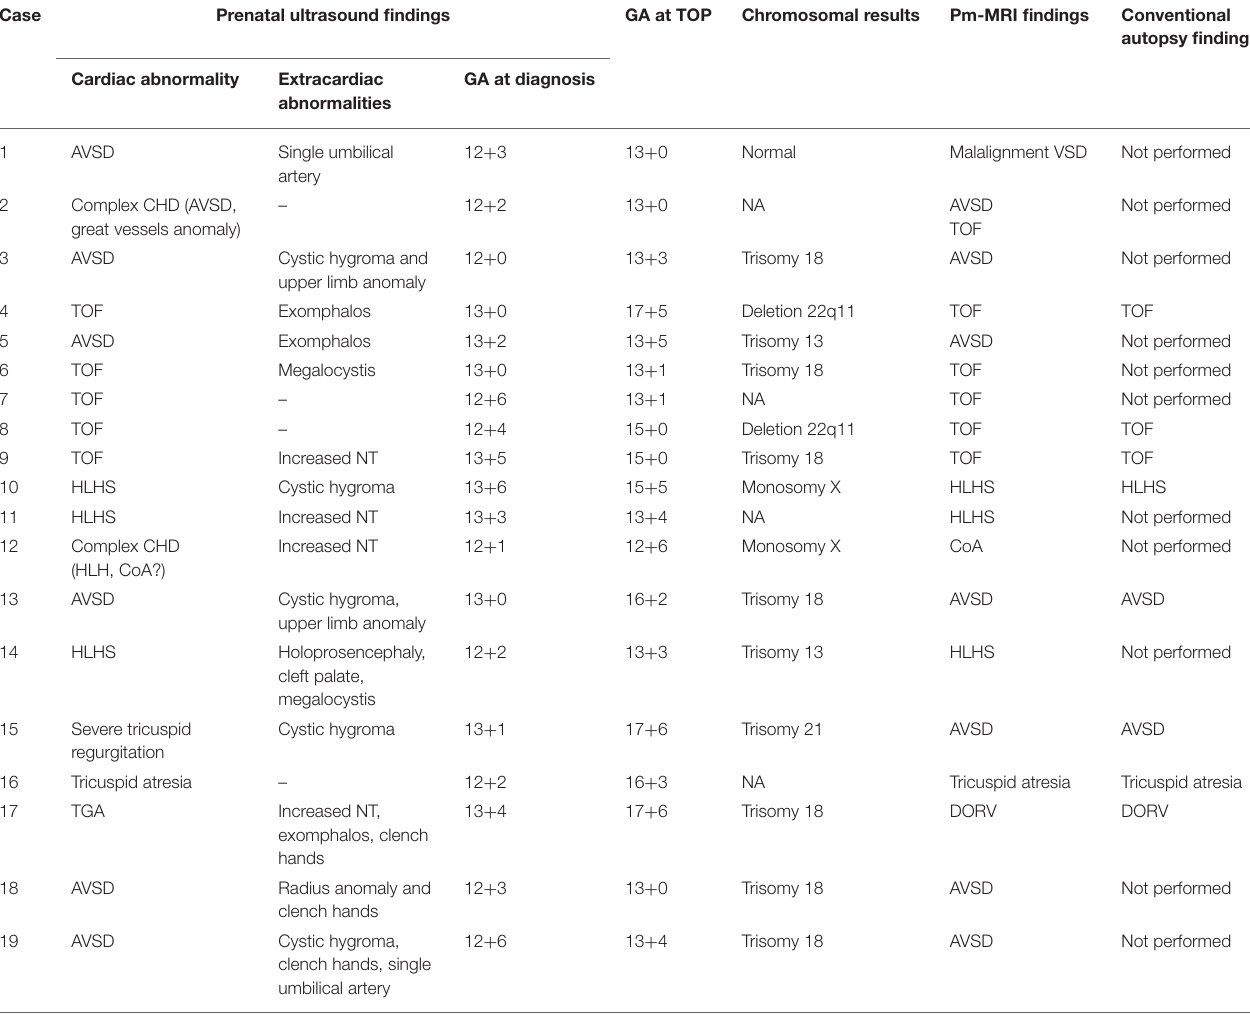
TABLE 2 | The prenatal diagnosis, postmortem MRI, and conventional autopsy findings in the 19 fetuses with abnormal cardiac findings.